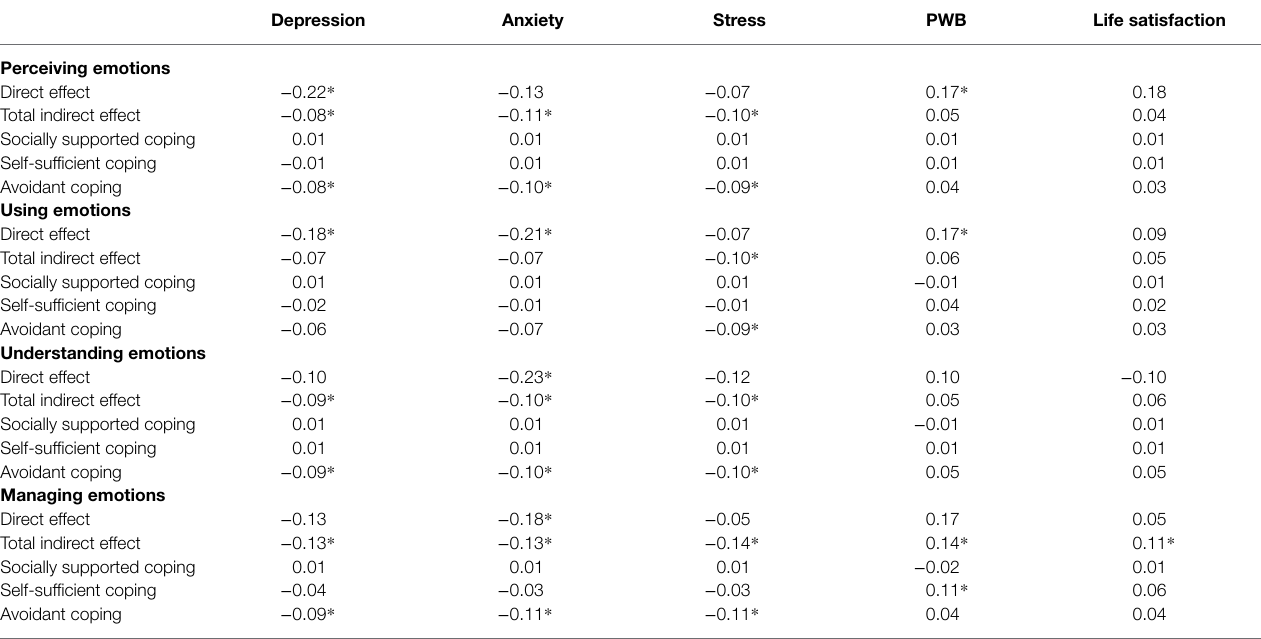
TABLE 4 | Indirect effects of EI on ill-being and well-being through coping (fully standardized estimates shown), Study 2, N = 115. Depression Anxiety Stress PWB Life